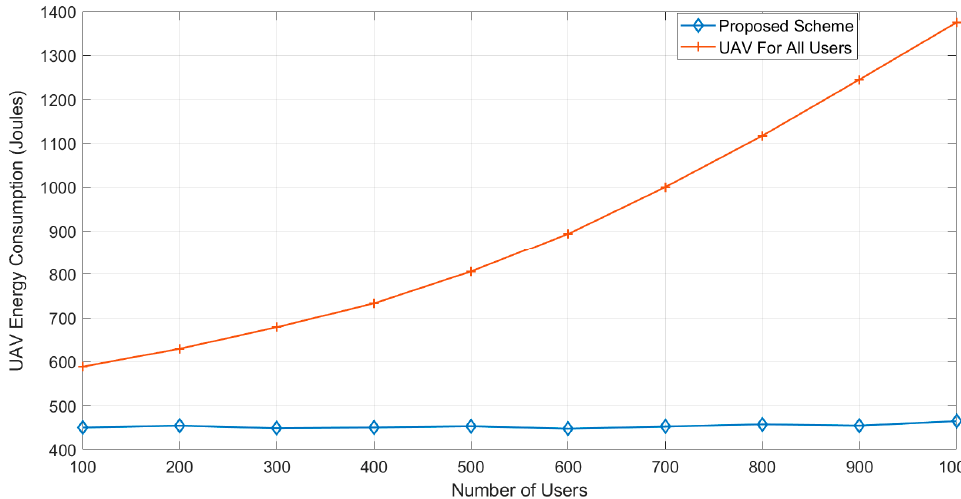
Figure 9. UAV energy consumption V/S number of users.